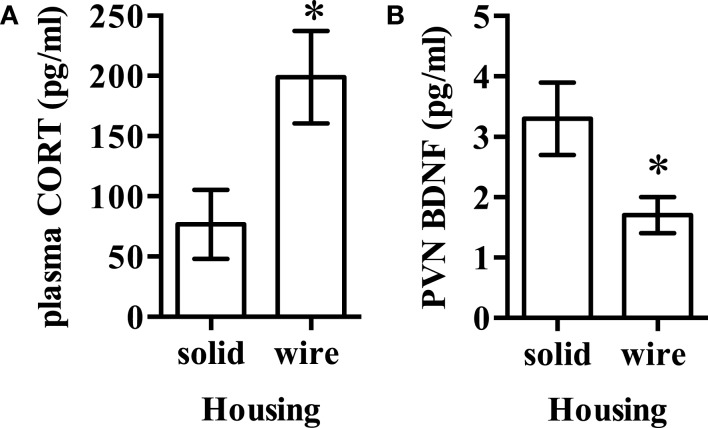
(A) Plasma corticosterone and (B) brain-derived neurotrophic factor (BDNF) in the hypothalamic paraventricular nucleus (PVN) was not significantly different after Bonferroni correction for multiple comparisons between rodents housed in either solid- or wire-bottom cages. Data represent mean ± SEM. Please note different y-axes. N = 20 (n = 10/housing strategy). *P < 0.05 as compared to solid-bottom housing.